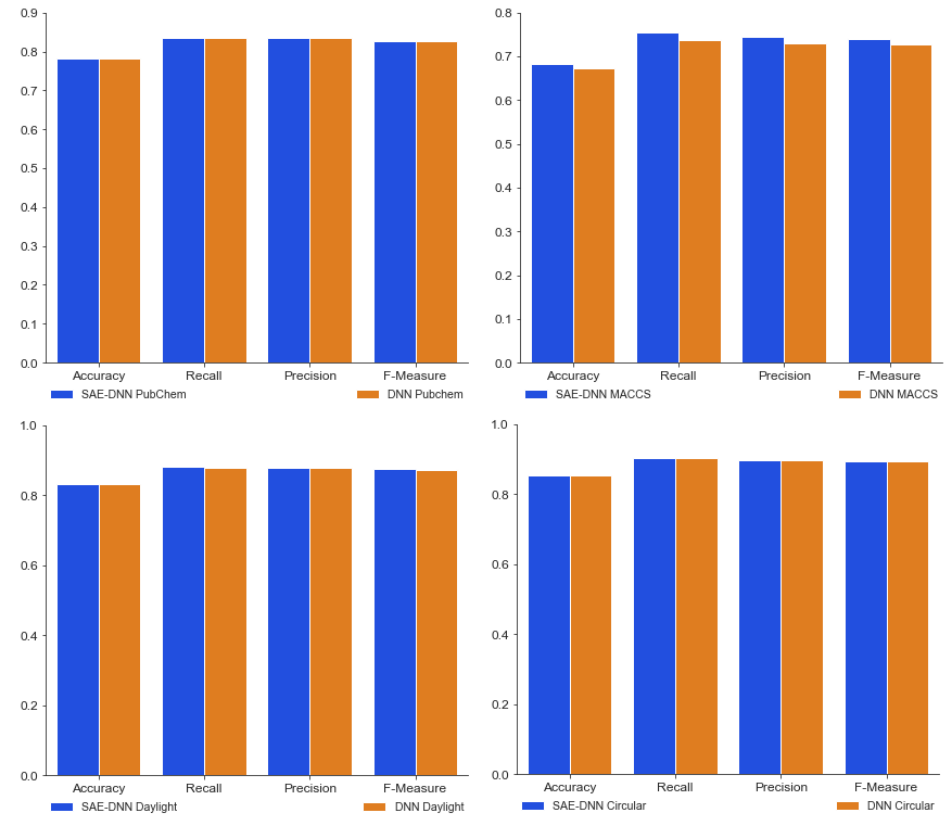
Figure 5. Performance results of SAE-DNN and DNN only for all feature extraction dataset.